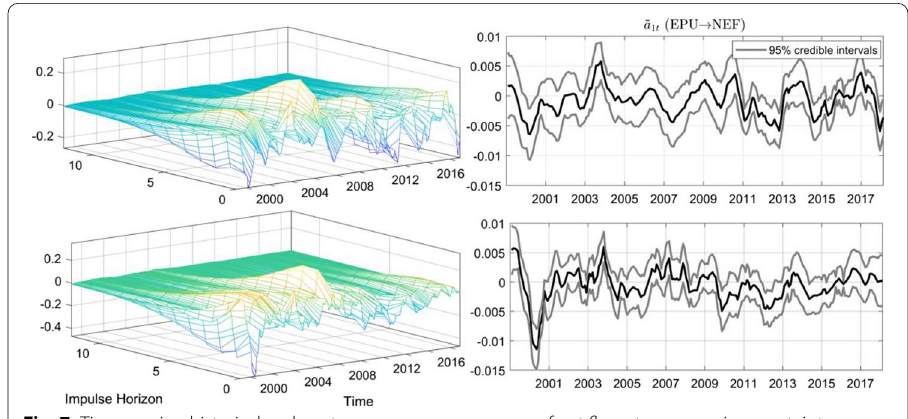
Fig. 7 Time-varying historical and contemporaneous responses of net flows to economic uncertainty shocks. Right panel: historical impulse responses. Left panel: Contemporaneous response. Top: Results from TVP-VAR-SV under the order { EPU , NEF , R } . Bottom: Results from TVP-VAR-SV under the order { EPU , R , NEF